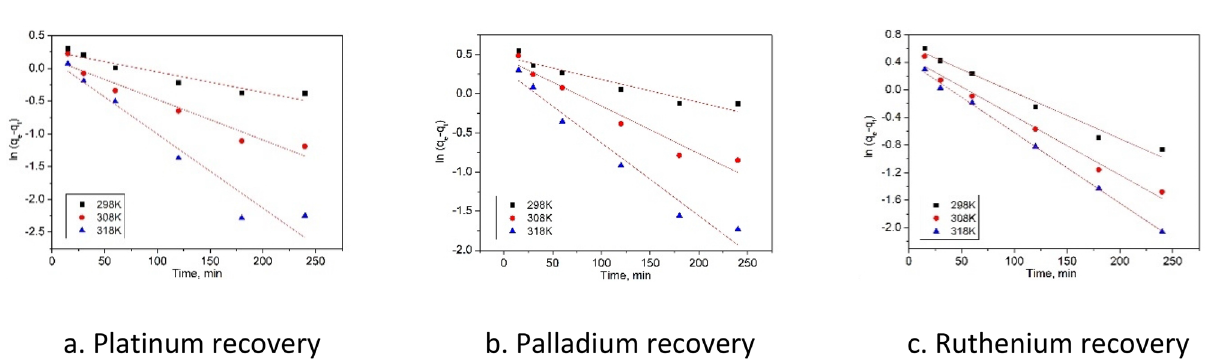
Figure 8. Preudo-first-order kinetic model of the Pt(IV), Pd(II) şi Ru(III) recovery by Ch-DB18C6.